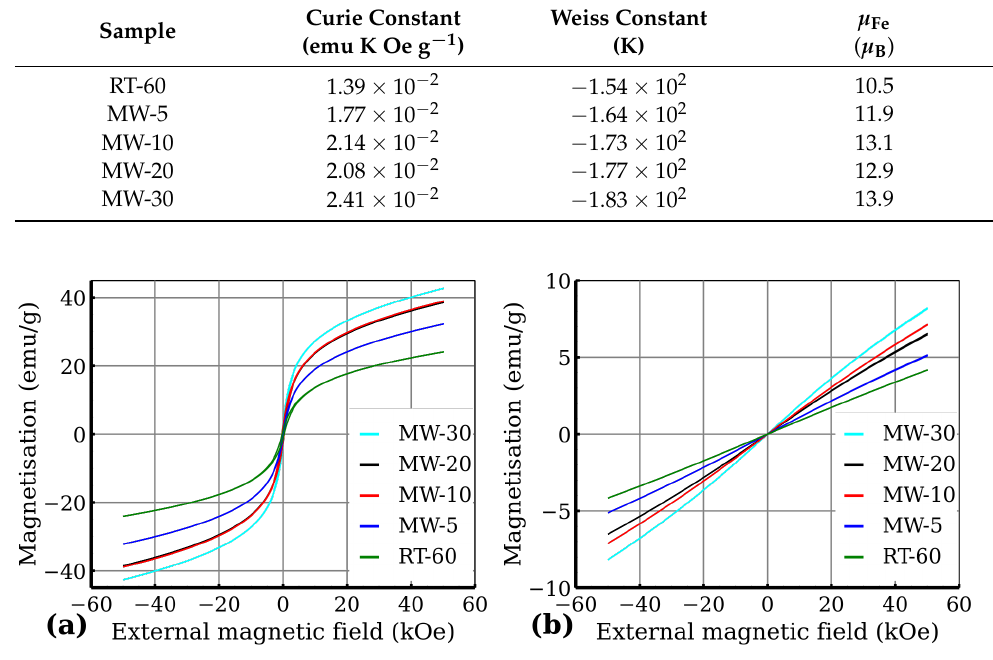
Figure 12. Hysteresis loops recorded at ( a ) 5K and ( b ) 300K.